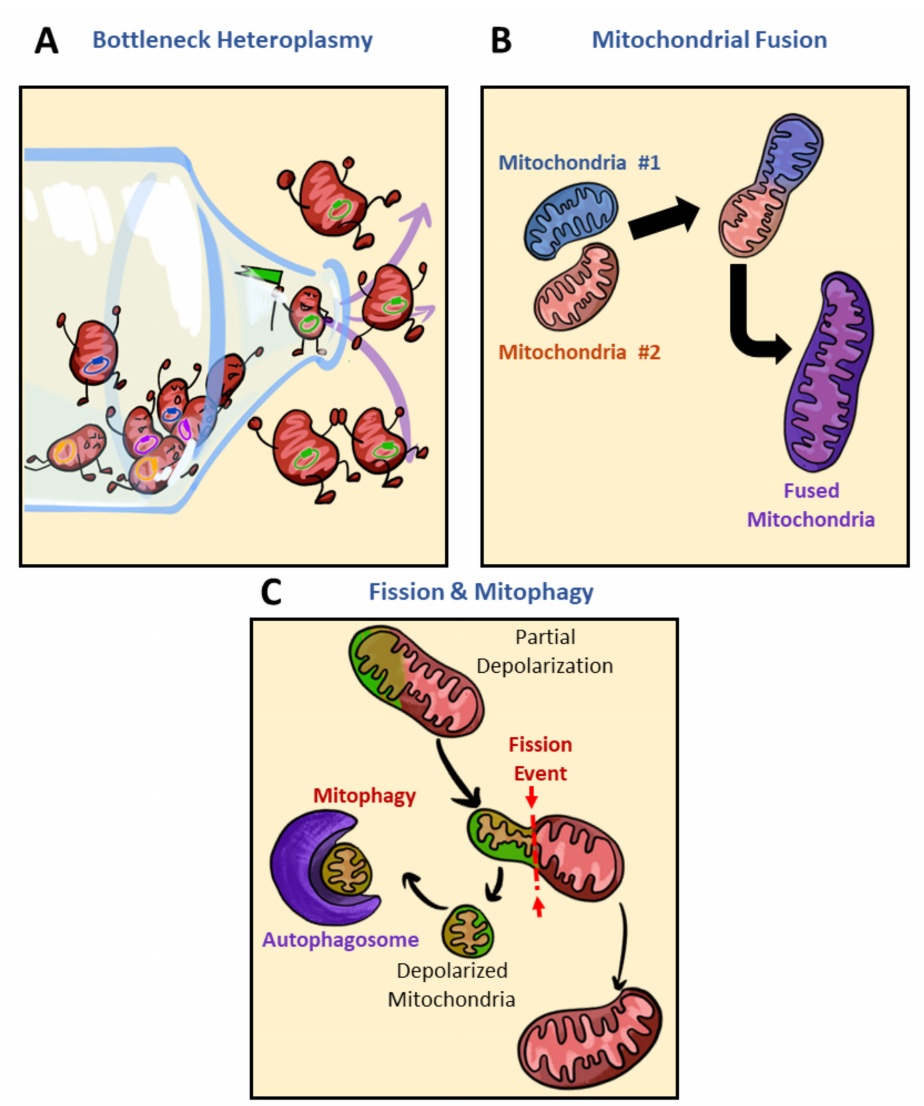
Figure 5. Reducers of mitochondrial heterogeneity. Potential sources of reducing mitochondrial heterogeneity include bottlenecking mitochondrial heteroplasmy, mitochondrial fusion, and mitophagy. ( A ) Though mitochondrial biogenesis has the potential to increase mitochondrial heterogeneity, in cases where the selection of mtDNA experiences a bottleneck effect mitochondrial heterogeneity is reduced. In this cartoon, the bottle containing various mtDNA (yellow, purple, blue, or green) is filtered to only one expression pattern of mtDNA, forcing homogeneity. Through mtDNA bottlenecking, daughter mitochondria of a biogenesis event can lose their heteroplasmic content in favor of one dominating mtDNA sequence variance (mitochondria with the green circle), thereby creating mitochondria that lack genetic diversity and reducing heterogeneity. ( B ) Mitochondrial fusion, though a normal part of the mitochondrial life cycle, can result in a decrease in mitochondrial heterogeneity. When two mitochondria with differing mitochondrial components fuse, their contents are combined, thereby reducing the number of genetic differences between mitochondria in the population. ( C ) Mitochondrial fission and mitophagy is another method by which mitochondrial heterogeneity can be decreased. Through mitochondrial fission, one mother mitochondrion is separated into two, with differences in their membrane potential, one depolarized mitochondrion (green) and the other hyperpolarized or of normal membrane potential (red). Removal of depolarized mitochondria reduces population heterogeneity by reducing the pool of mitochondria with sustained depolarized membrane potential. Polarized mitochondria (red); depolarized mitochondria (green); autophagosome